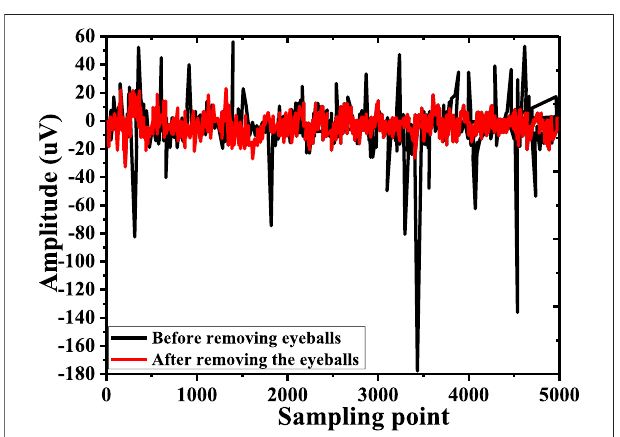
FIGURE 8 | EEG before and after removing electro-oculogram